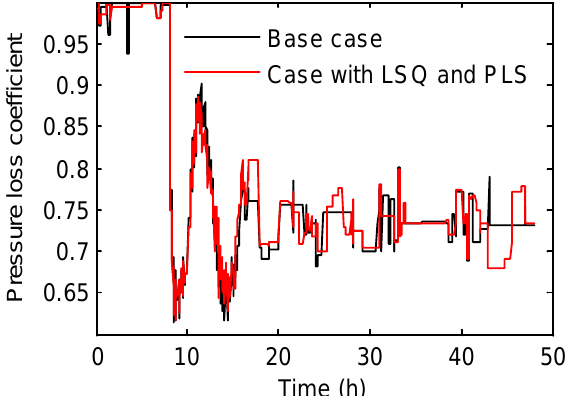
Figure 10. Fault diagnosis of fault 7 with the hybrid algorithm.